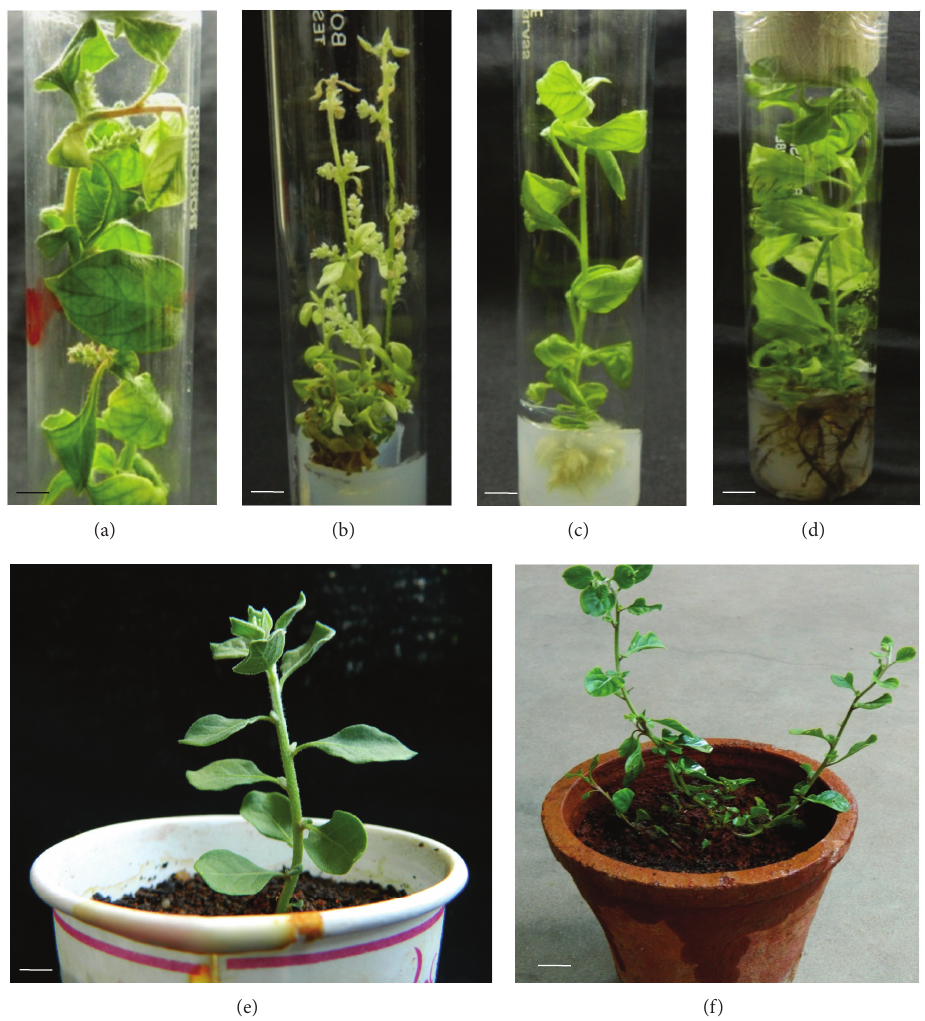
Figure 2: In vitro flowering and acclimatization of A. lanata . (a) In vitro flowering on MS medium containing 1mg L −1 TDZ and 0.25 mgL −1